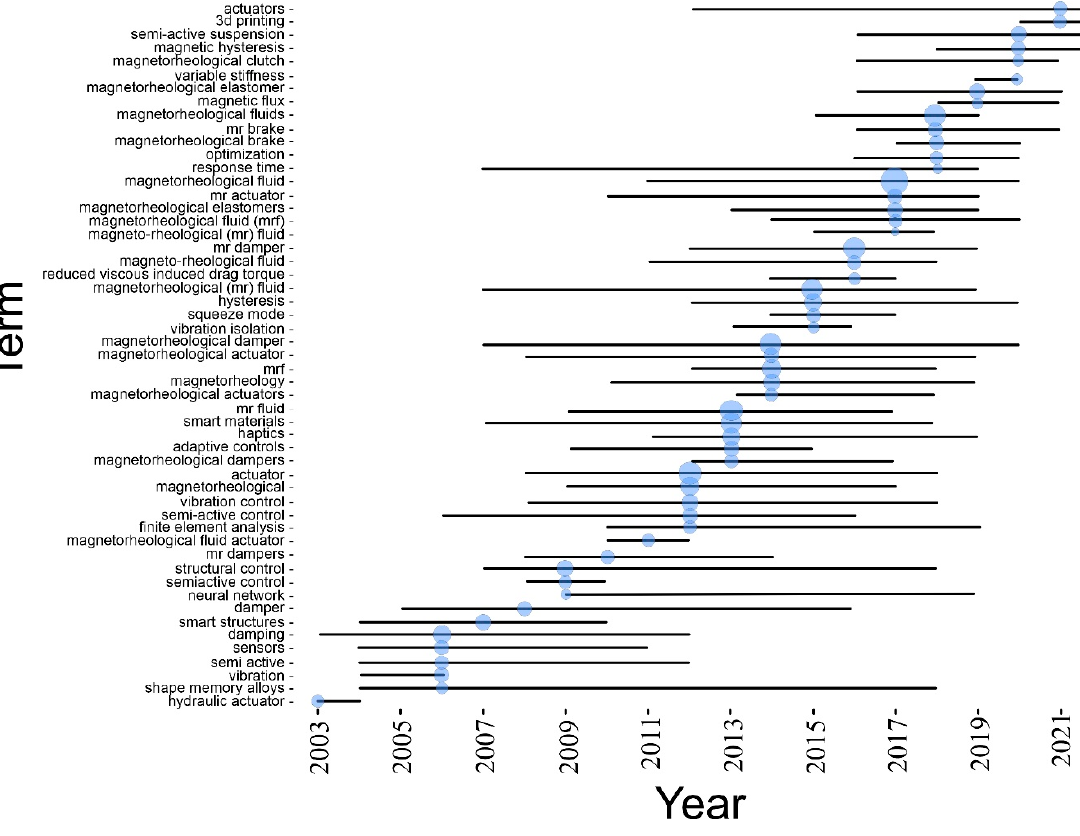
Figure 21. Trend topic of the control strategy used in the magnetorheological actuator.